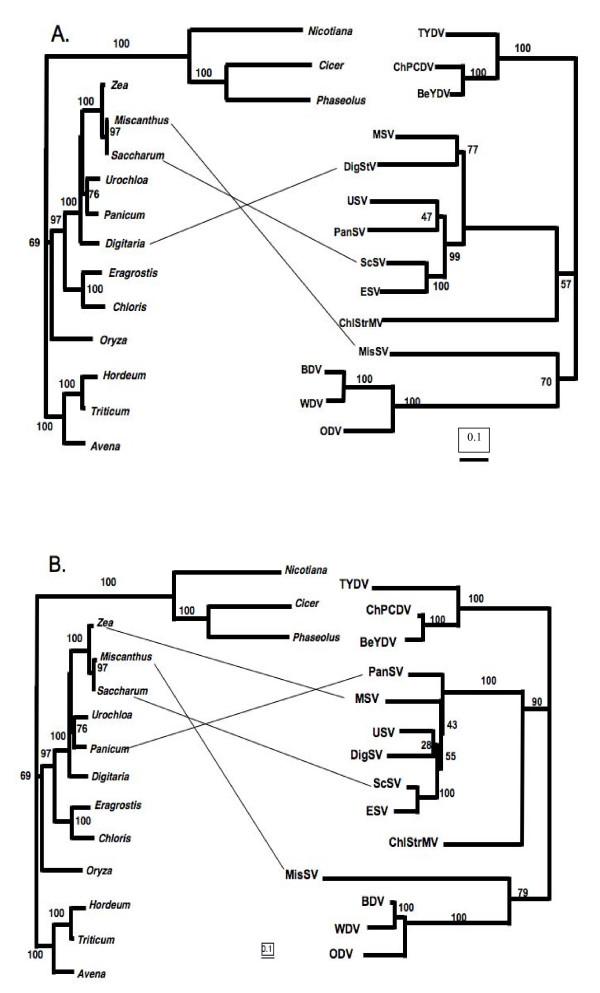
Tangle-gram of phylogenetic relationships of host plants (left, rbcL gene sequences) and (right) mastreviruses infecting those plants. A. Virus tree based on Rep and Rep A coding regions. B. Virus tree based on MP-CP coding regions. Accession numbers of the rbcL gene sequences used are as follows: AJ746257Avena fatua; EU196765Phaseolus vulgaris; AM235066Miscanthus capensis; AY632368Panicum virgatum; EU492898Triticum aestivum; AM849336Digitaria ciliaris; Z00044Nicotiana tabacum; X86563Zea mays; EF115541Hordeum vulgare; AM849409Chloris gayana; AP006714Saccharum officinarum; AM849338Eragrostis minor; AF308707Cicer arietinum; AY522330Oryza sativa; AM849390Urochloa maxima.